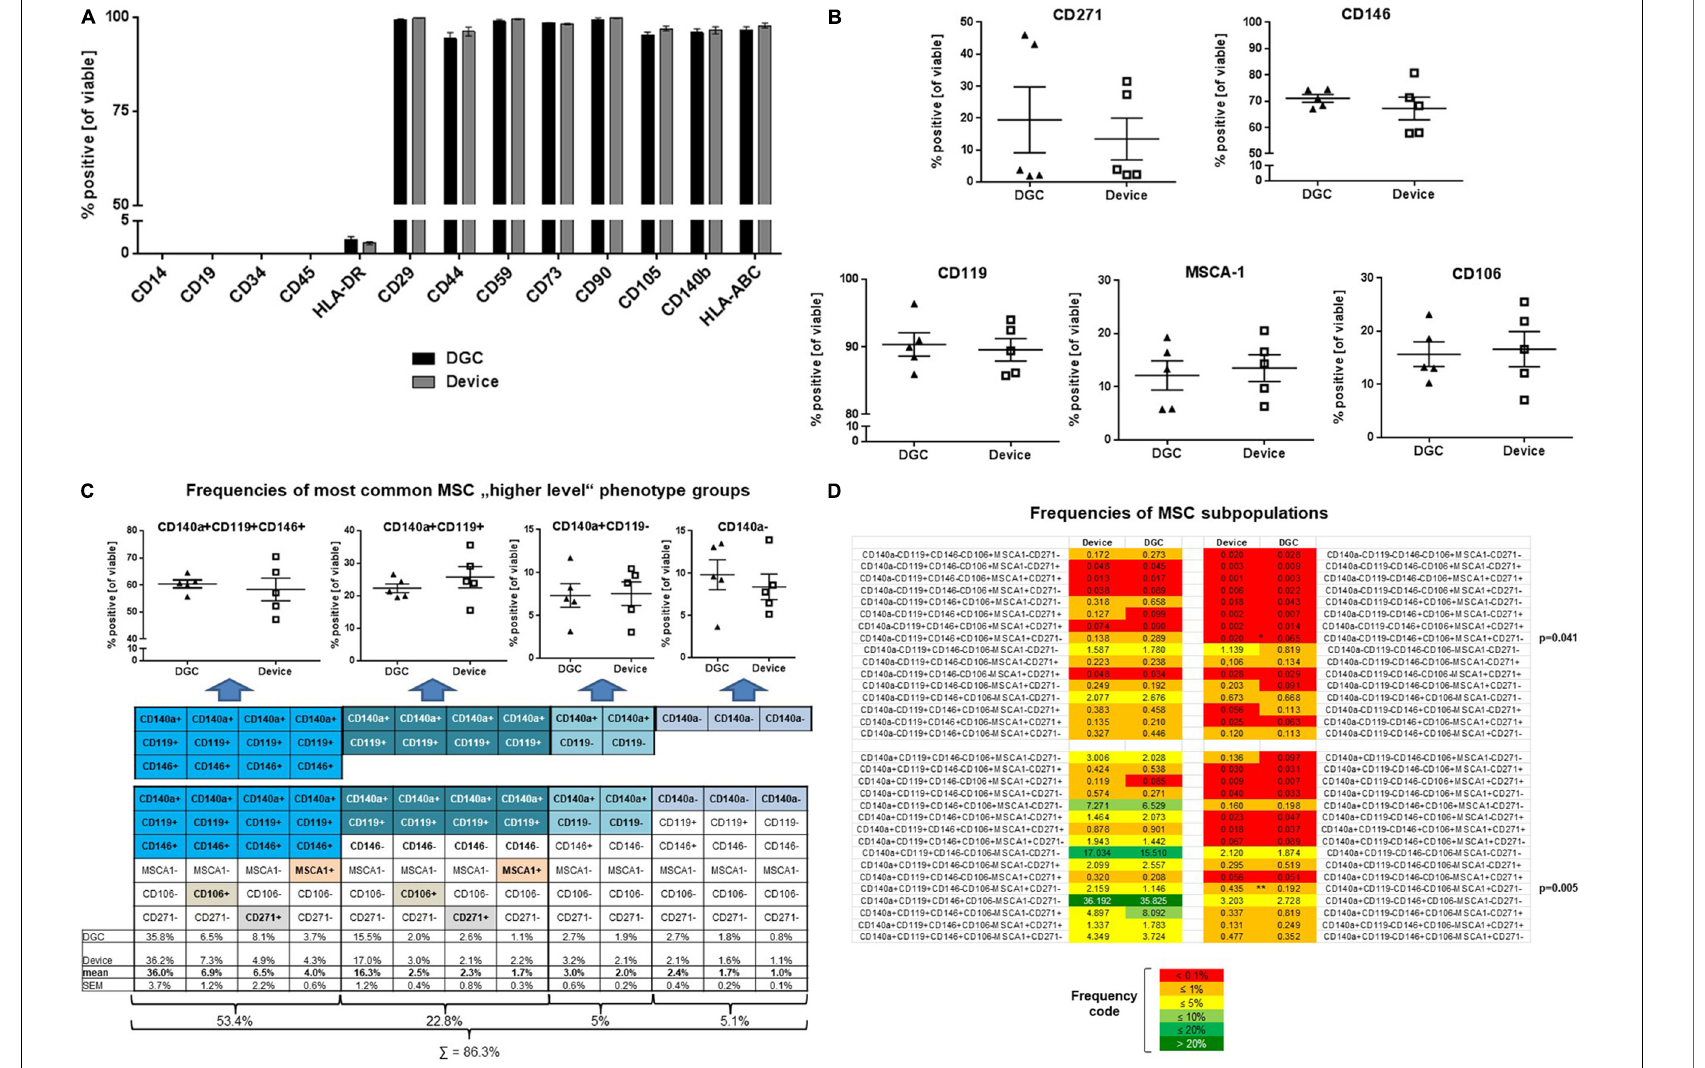
FIGURE 4 | MSC surface marker phenotyping. Flow cytometry analyses of typical MSC markers, HLA class II, and hematopoietic markers at P3 (A) . Data are presented as means ( n = 5 donors). Error bars: SEM. Prevalence of MSC subpopulation markers (B) , frequencies (in %) of “higher-level” MSC phenotype groups (C) , and MSC subpopulations (D) identified and quantified by multicolor flow cytometry at P3. Data are presented as means ( n = 5 donors); data points in B and C represent individual donors. Error bars: SEM. One-way ANOVA. P -values are only shown for statistically significant